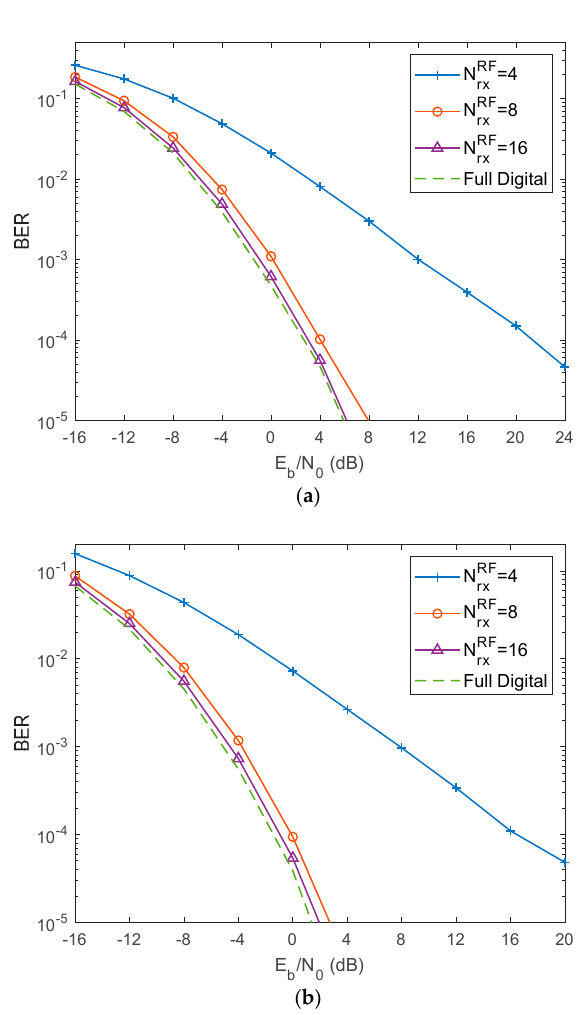
Figure 3. Performance comparison of the proposed hybrid precoders with the full digital system for N tx = 8 and N rx = 32: ( a ) random-based precoder, ( b ) angle of departure (AoD)-based